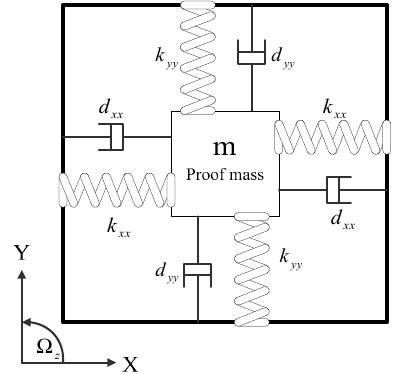
Figure 1. Schematic model for a gyroscope.